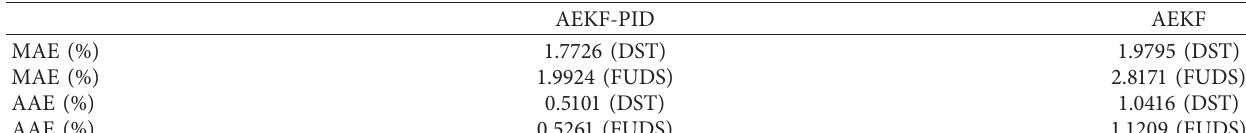
Table 2: SOC estimation with Gaussian noise.